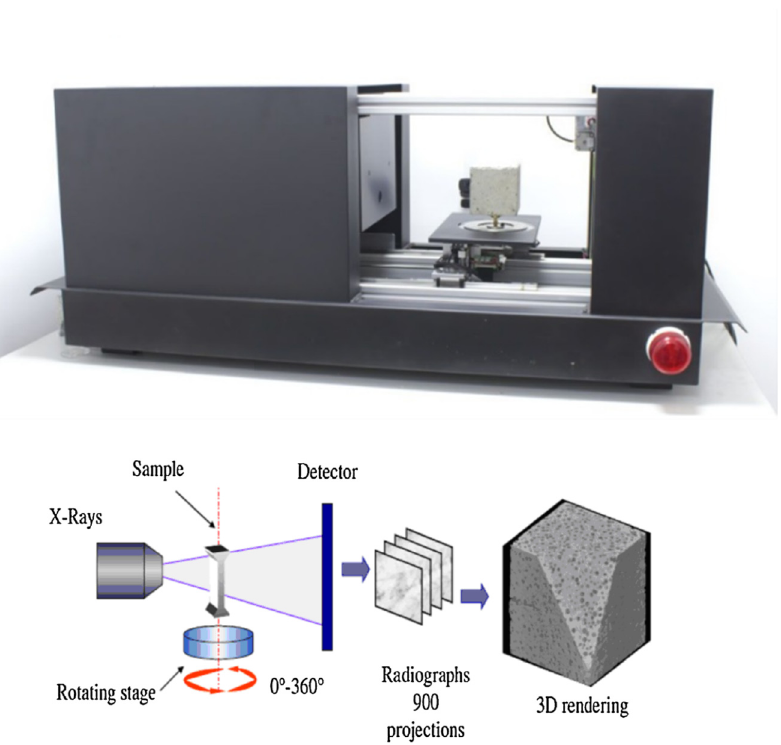
Figure 2. X-ray Computed Tomography SkyScan 1173 and the operation principles of X-ray micro-CT.